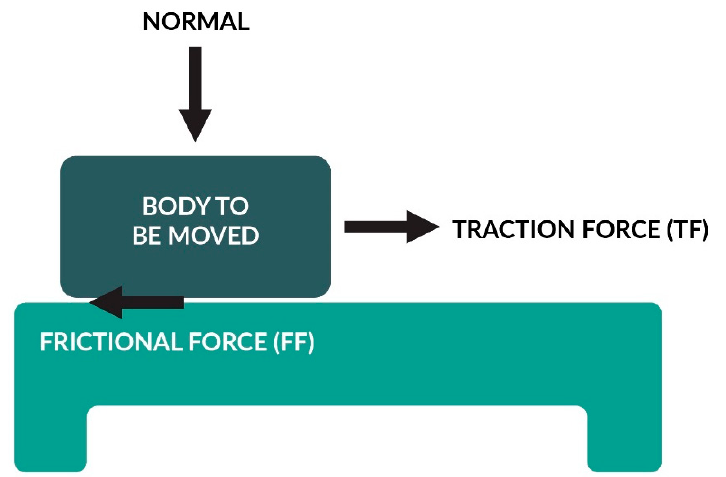
Figure 3. Different forces acting over a body under traction on top of a surface. Body to be moved, traction force (TF), friction force (FF), contact surface (CS).